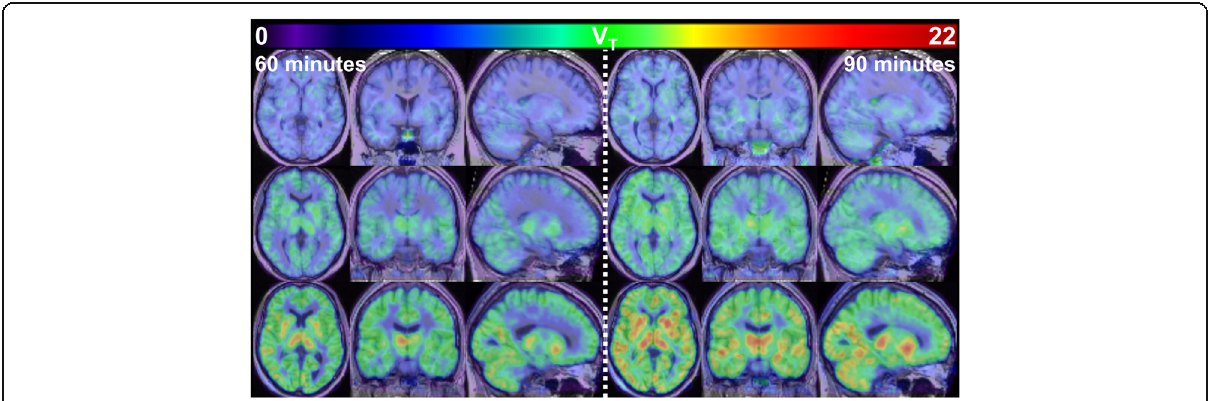
Fig. 3 Original ppIF-derived V T images calculated using 60-min (left panel) and 90-min (right panel) datasets. Colour scale — original ppIF-derived — participant with epilepsy on antidepressants (epilepsy — antid. 2); middle row — control participant (control 2); bottom row — participant V T ; top row with epilepsy, not on antidepressants (epilepsy 5). Images are shown in radiological